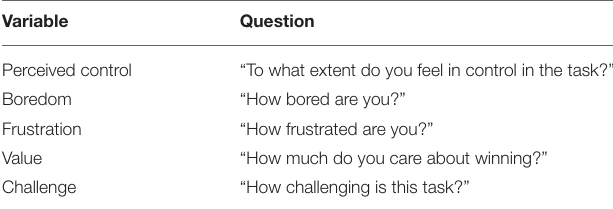
TABLE 1 | Study variables and probe